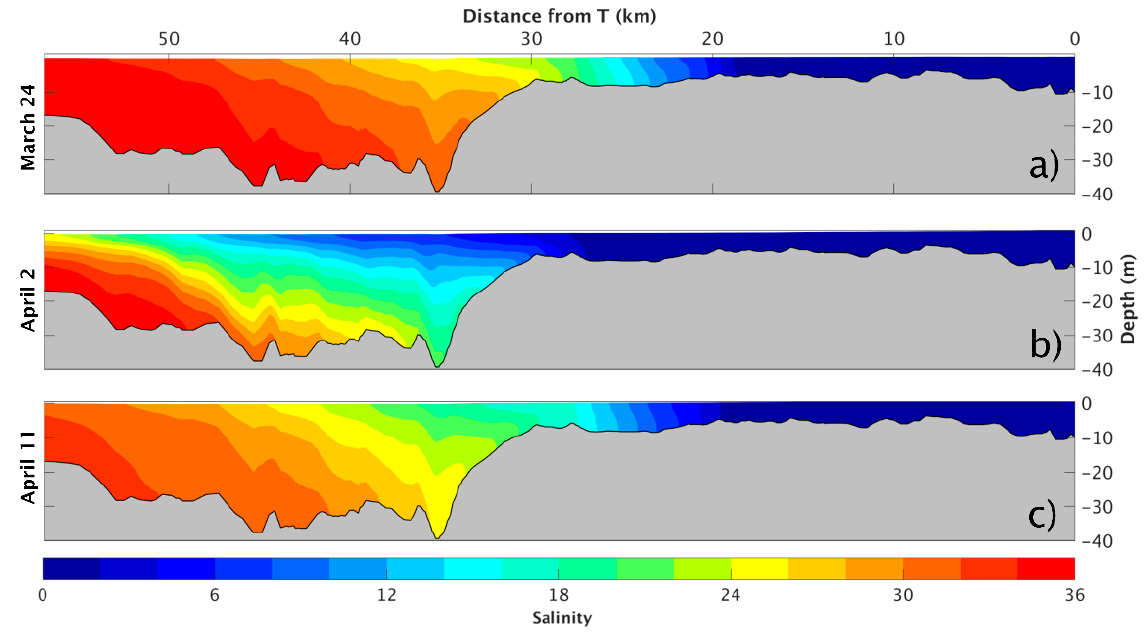
Figure 4. Daily averaged vertical salinity profiles along the longitudinal section to the estuary (#ScRef); ( a ) 24 March; ( b ) 2 April; ( c ) 11 April, before, during, and after the extreme freshwater discharge event, respectively.